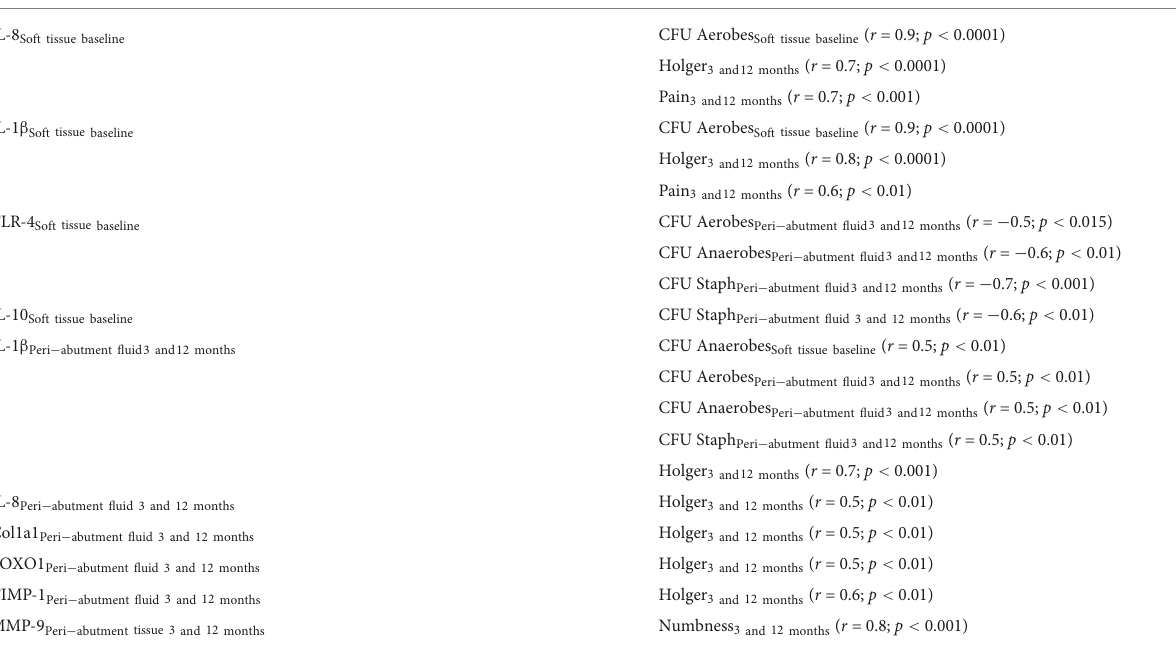
TABLE 1 Pearson correlation analysis of gene expression with microbiological and clinical findings (data pooled for the 3-month and 12-month time points). Genes Correlation with microbiological and clinical parameters IL-8 Soft tissue baseline CFU Aerobes Soft tissue baseline ( r = 0.9; p < 0.0001) Holger 3 and12 months ( r = 0.7; p < 0.0001) Pain 3 and12 months ( r = 0.7; p <